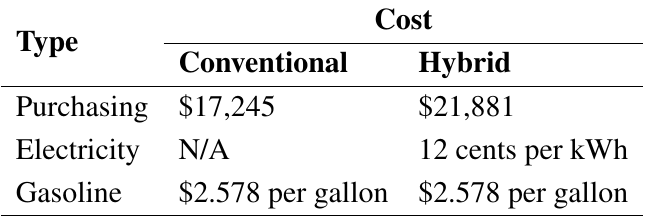
Table 4. Cost breakdown of conventional and hybrid